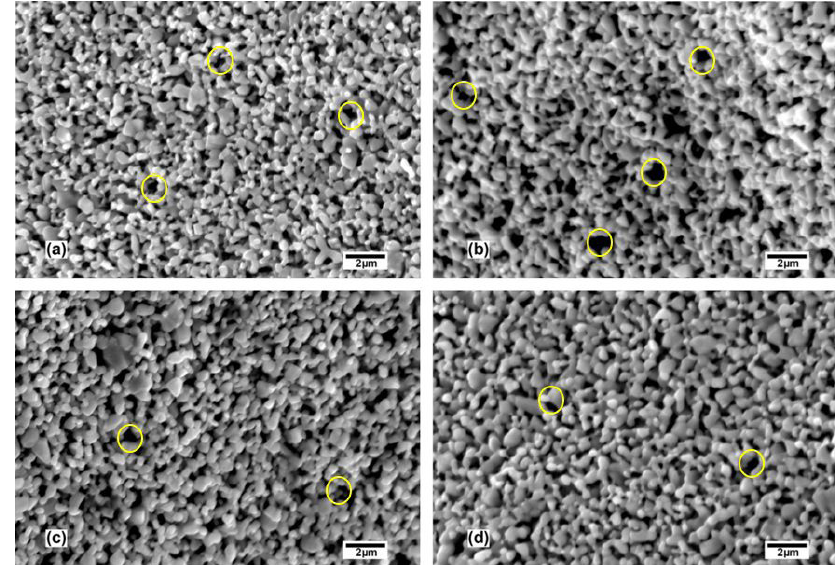
Figure 5. Micrographs of heat-treated ZnO ceramics at 800°C/2h with compositions (a) 60/3, (b) 65/3, (c) 65/1, and (d) 70/1 to evaluate the effect of temperature on porosity.